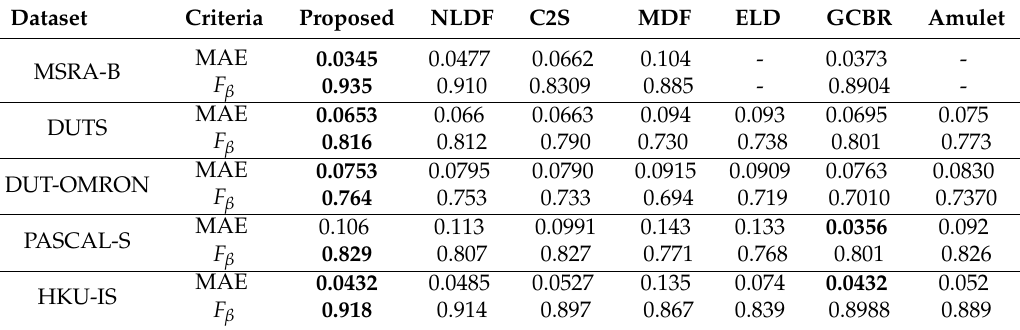
Figure 7. ( left ) Precision–recall (PR) and ( right ) F-measure curves of proposed model (SODL) and state-of-the-art (SOA) models. Table 2. Comparison of proposed method with SOA methods on five datasets in terms of F-measure (larger is better) and MAE (smaller is better). Note: NLDF, nonlocal features; C2S, contour to saliency; MDF, multiscale deep CNN features; ELD, deep saliency with encoded low-level distance map and high-level features; GCBR, salient-object detection in low-contrast images via global convolution and boundary refinement; Amulet, aggregating multilevel convolutional features for salient-object